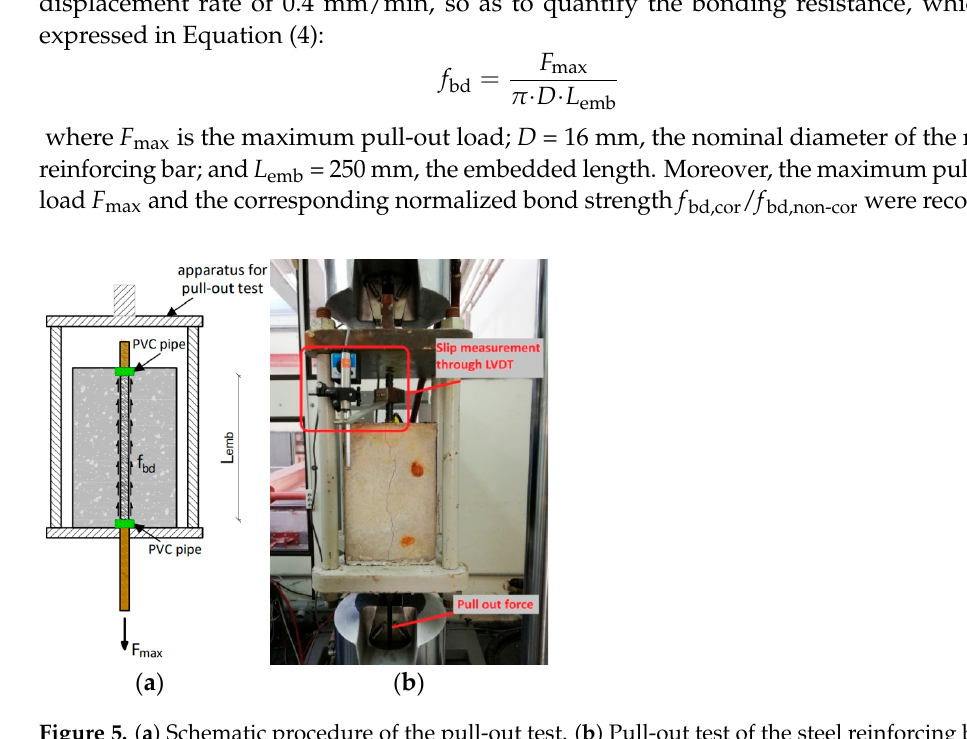
Figure 5. ( a ) Schematic procedure of the pull-out test. ( b ) Pull-out test of the steel reinforcing bar.